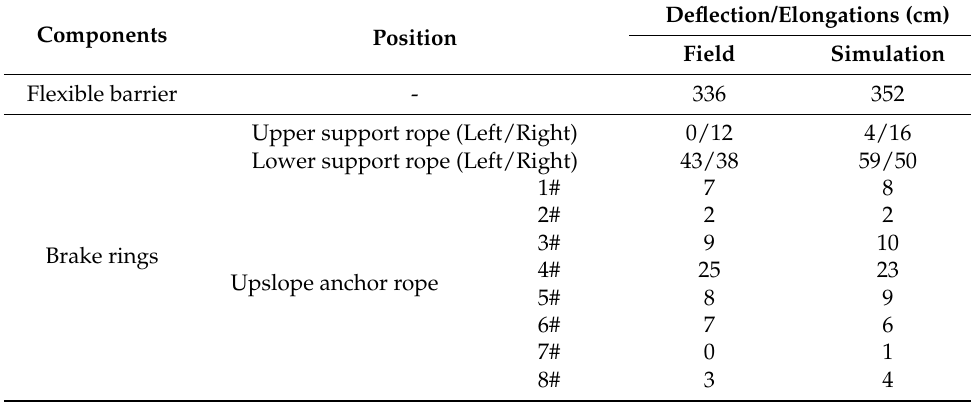
Table 3. Deflection of the flexible barrier and elongation of the brake rings.